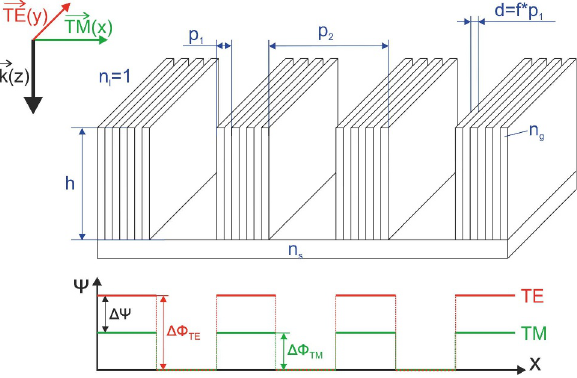
Figure 3. Cross section of subwavelength-structured di ff rac- tion grating ( p 1 = 500nm , p 2 = 10 µ m , h = 700nm) in Sili- con [7] Below, the relative phase shifts between TE- and TM- polarization are